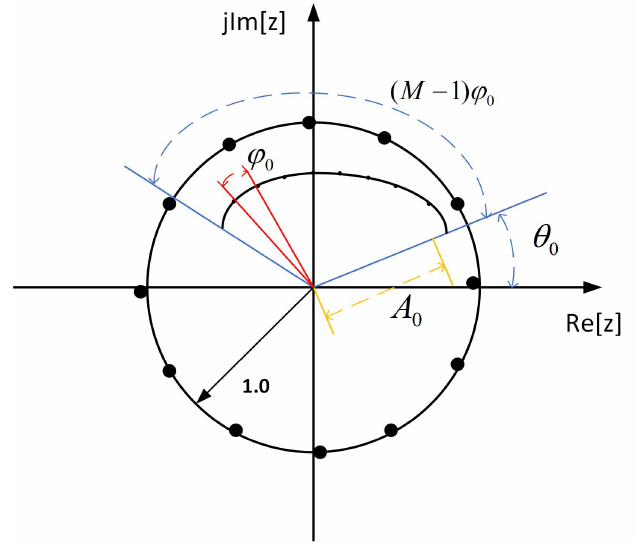
Figure 6. Z-plane unit circle representation of the CZT.